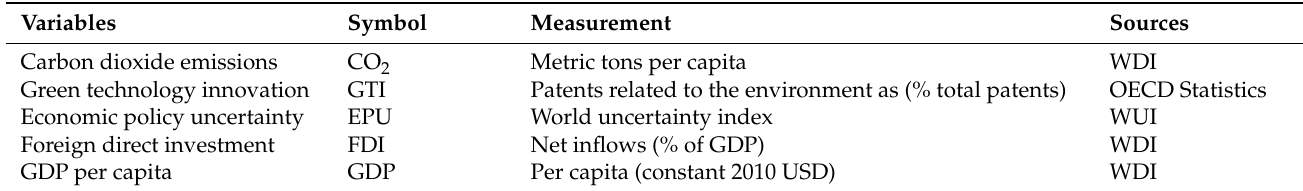
Table 2. Variable’s description and data